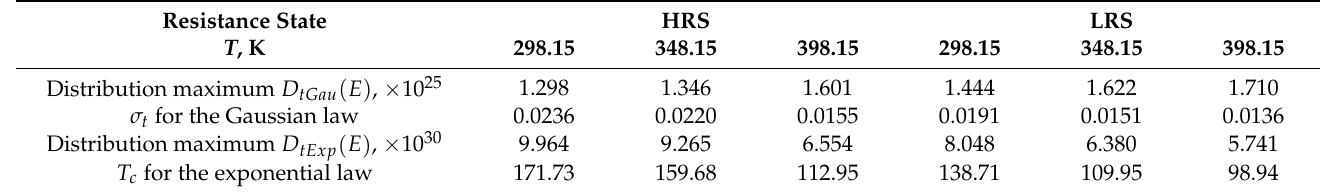
Table 2. Parameters for the Gaussian and exponential